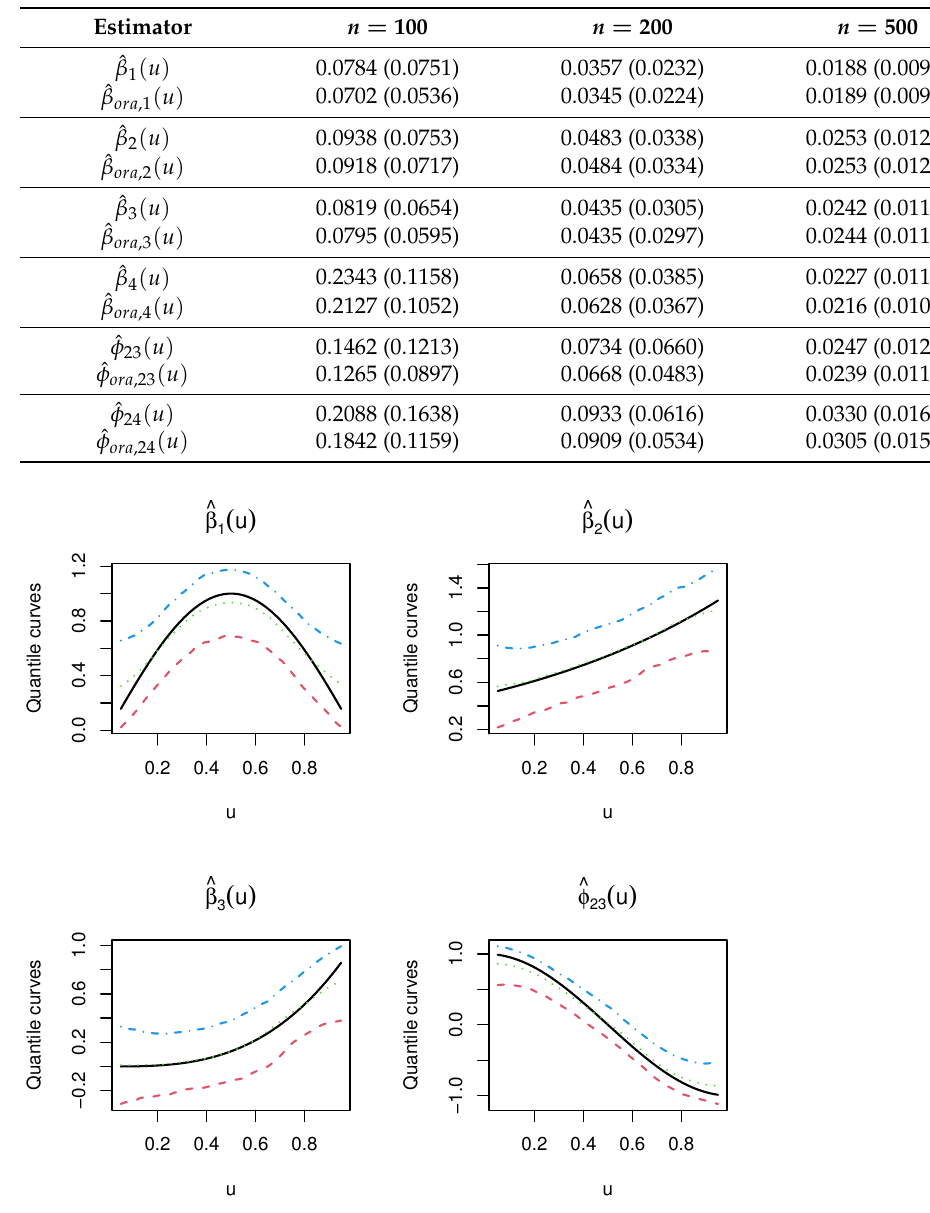
Table 3. MISEs of the functional coefficients estimators for Model 3.